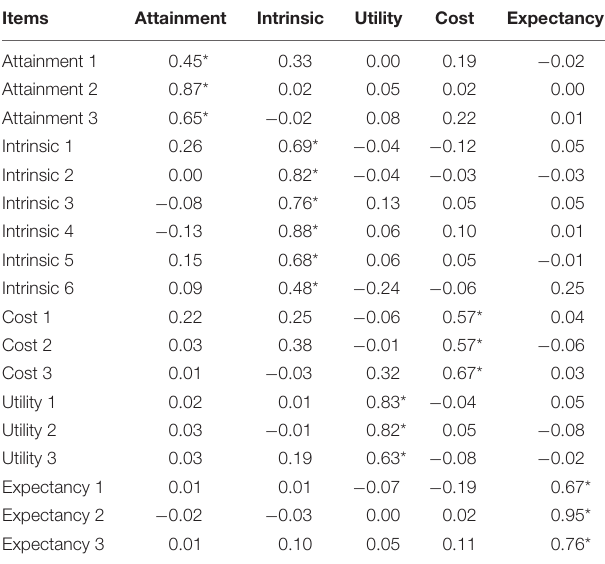
TABLE 2 | ESEM factor loadings of the expectancy-value motivation